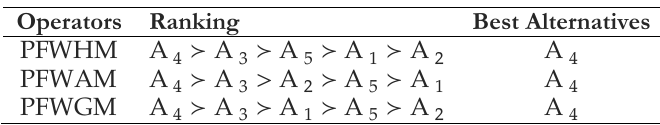
(𝐢 = 𝟏, 𝟐, ⋯ , 𝟓) in accordance with the values 𝐢 of 𝐒(𝐝 𝐢 ) (𝐢 = 𝟏,𝟐,⋯ ,𝟓)